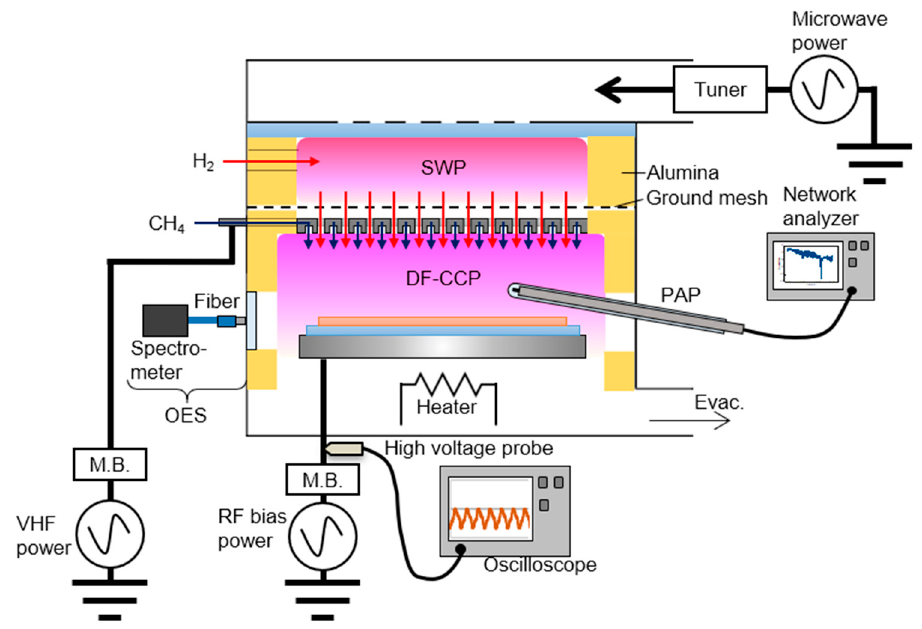
Figure 1. The schematic diagram of radical-injection plasma enhanced chemical vapor deposition (RI-PECVD) system with equipment for optical emission spectroscopy (OES), plasma absorption probe (PAP) method, and radio frequency (RF) bias voltage measurement.